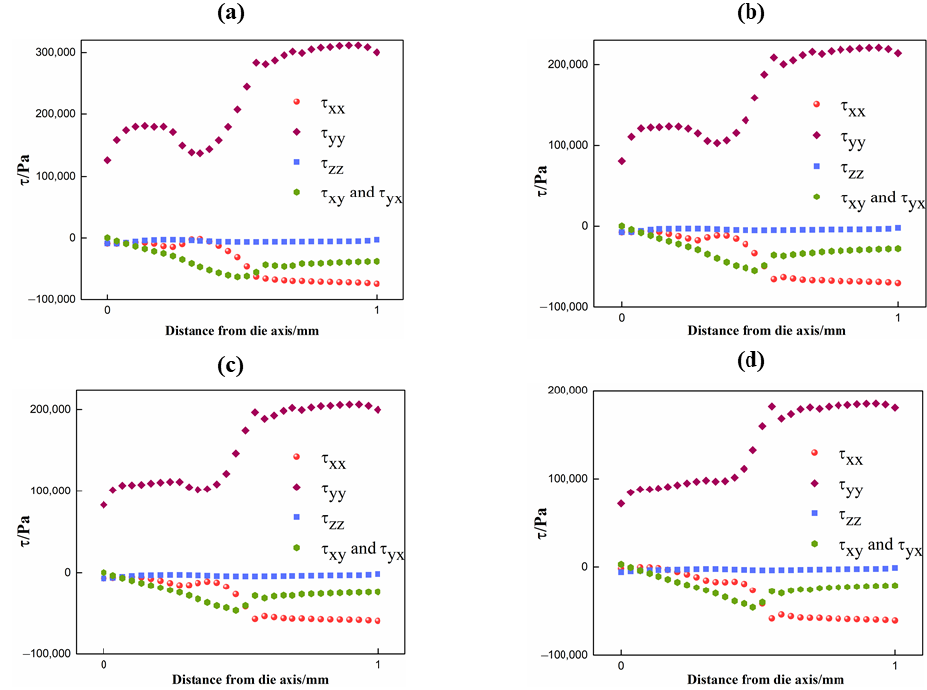
Figure 8. Distribution of stress components along the die exit: ( a ) 271 °C; ( b ) 274 °C; ( c ) 277 °C; ( d ) 280 °C.